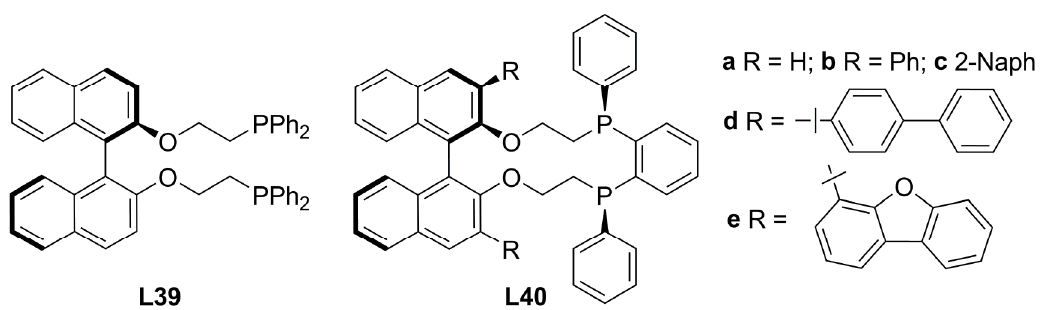
Figure 16. High-membered